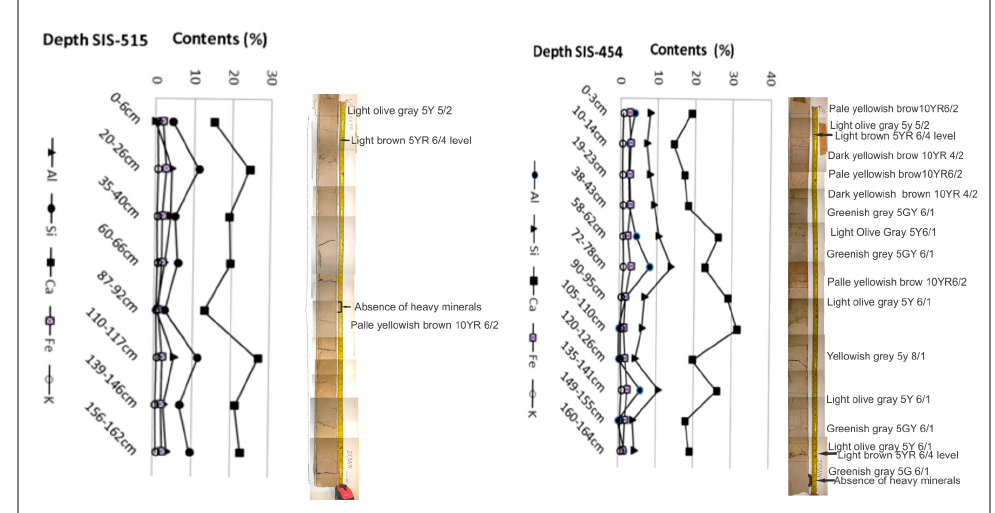
Figure 9 - Features of cores SIS-454 and SIS-515 including Al, Si, Ca, Fe and K contents and colors Table 1 - Correlation matrix of element contents of cores SIS-515 and SIS-454 Al 2 O 3